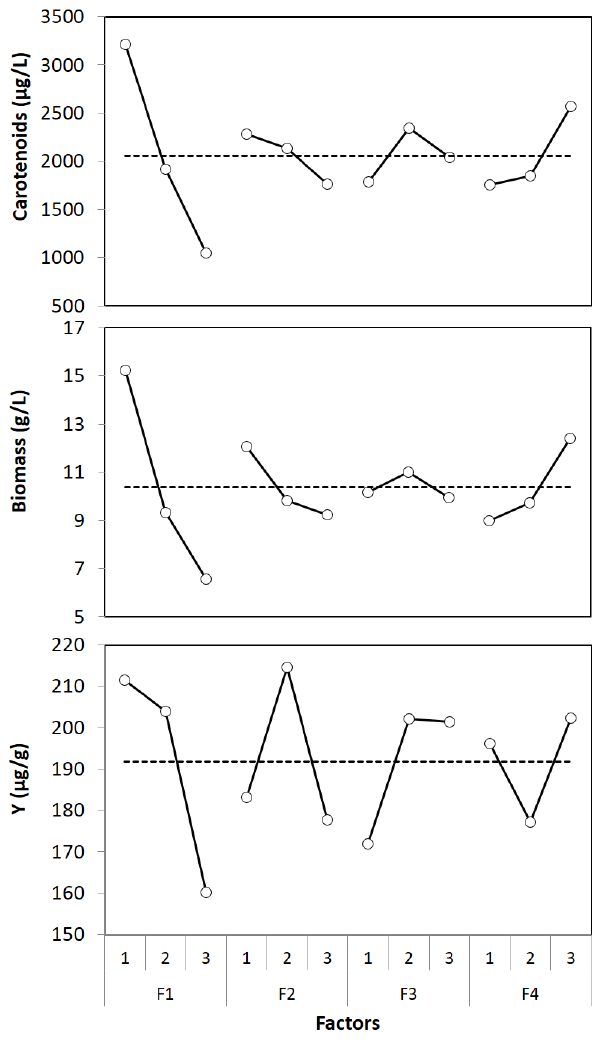
Figure 1. Individual influence of each factor evaluated on carotenoid production.